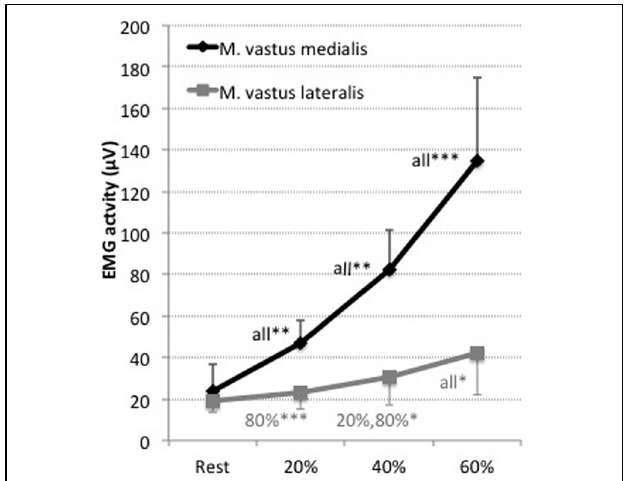
FIGURE 2 | EMG activity ( µ V) of the Musculus vastus medialis (black) and Musculus vastus lateralis (gray) for the measurements at 20, 40, 60, and 80% of the maximal voluntary contraction during leg extension. Shown are the mean values and the standard deviations (bars). Significant differences are indicated by ∗ p < 0 . 05, ∗∗ p < 0 . 01, ∗∗∗ p < 0 . 001 plus the corresponding measurement it is different to. Results are presented as mean ± standard deviation. Corresponding results of ANOVA are presented in Table 1